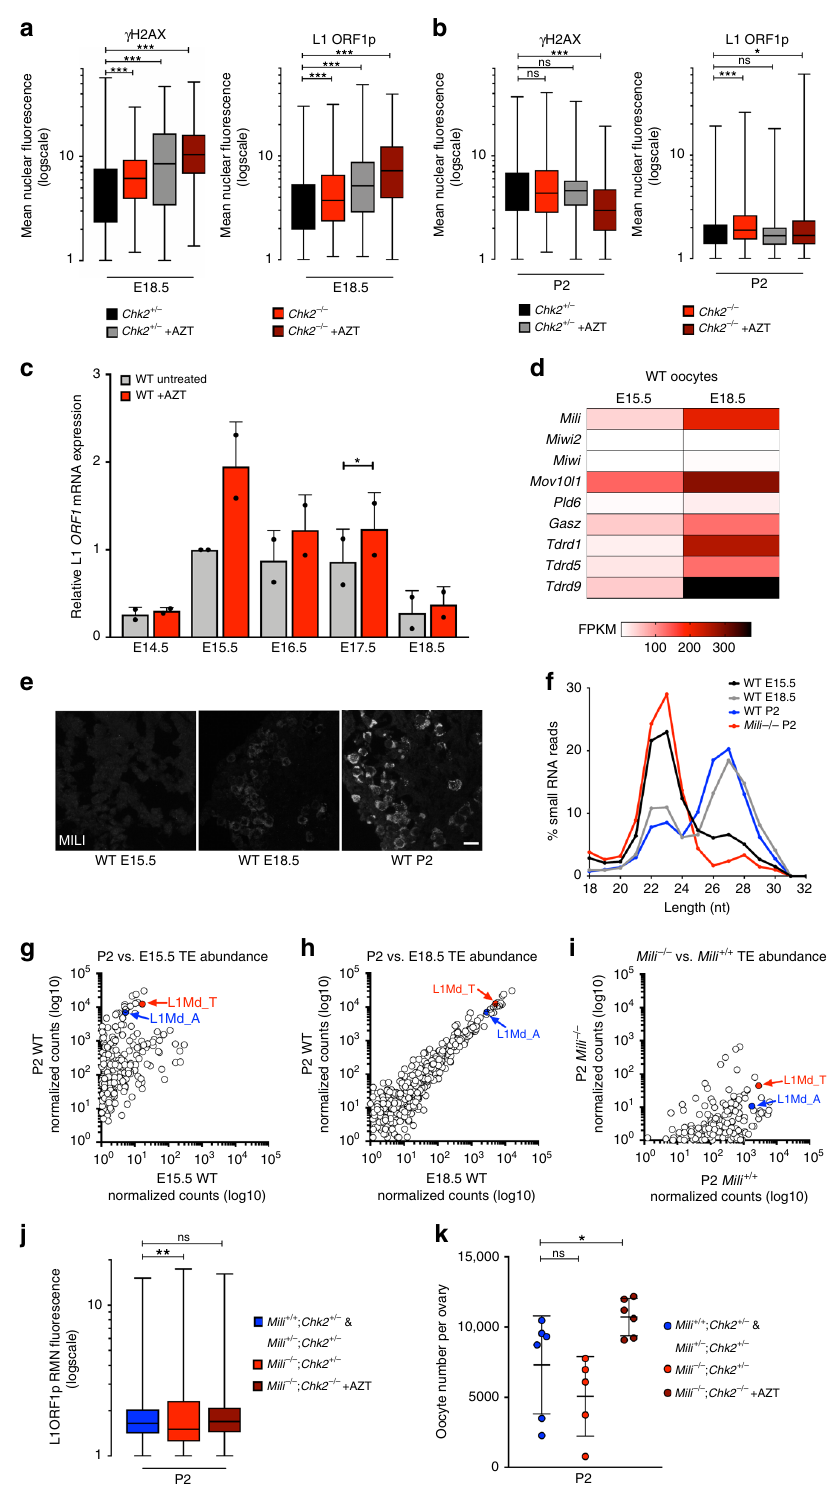
110 Mili –/– ; Chk2 +/– Mili –/– ; Chk2 +/– Mili –/– ; Chk2 –/– +AZT Mili –/– ; Chk2 –/– +AZT (Fig. 4g). Importantly, quanti fi cation of primordial and non- have reached reproductive maturity to Chk2 + / − males and primordial follicles revealed an increase in total follicles upon monitored the number of litters and litter size compared to FOA evasion in P4 and P19 stages (Fig. 4h and Supplementary untreated Chk2 − / − and Chk2 + / − females. Both litter number and Data 7a, b). Therefore, increasing the oocyte supply by preventing litter size over 10 months was comparable between the three FOA can increase the ovarian reserve into juvenile aged mice. conditions, suggesting that FOA is not obligatory for fertility, nor To test the effect of increased follicle number on fertility, we is it detrimental to have an increased number of follicles in the crossed females born to Chk2 − / − + AZT-treated females that ovarian reserve (Fig. 4i, j and Supplementary Data 7c – f). NATURE COMMUNICATIONS| (2020) 11:330